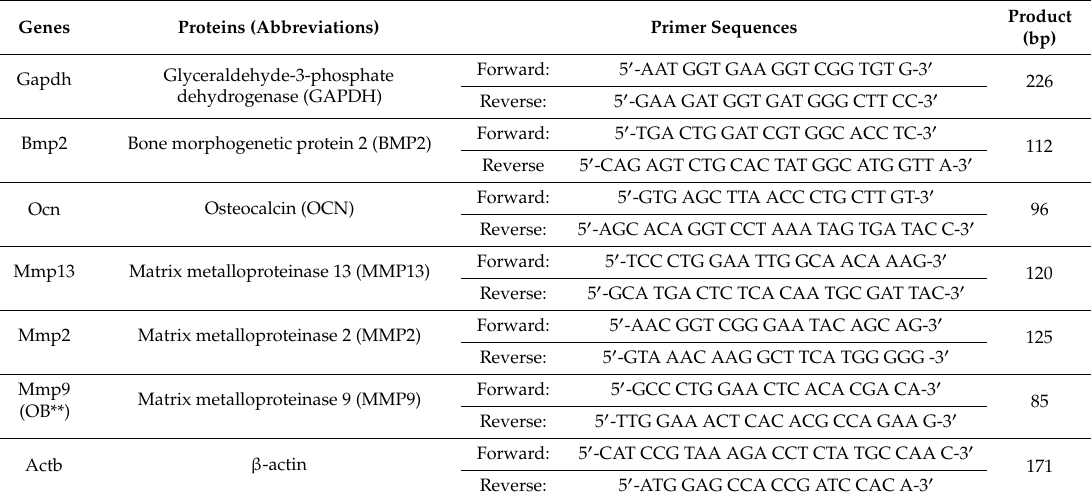
Table 1. Primer sequences for